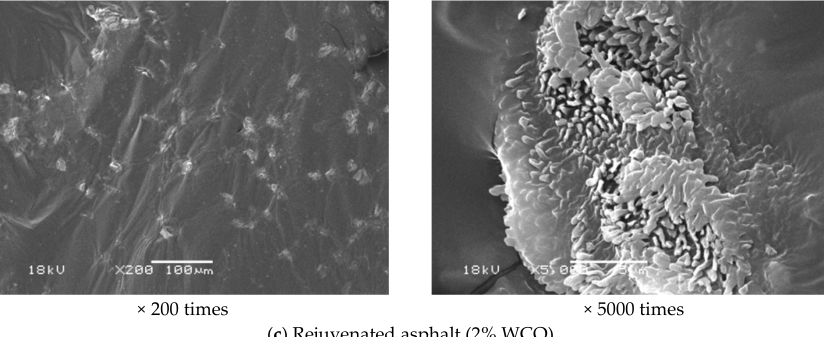
Figure 18. The SEM images of different asphalt states.